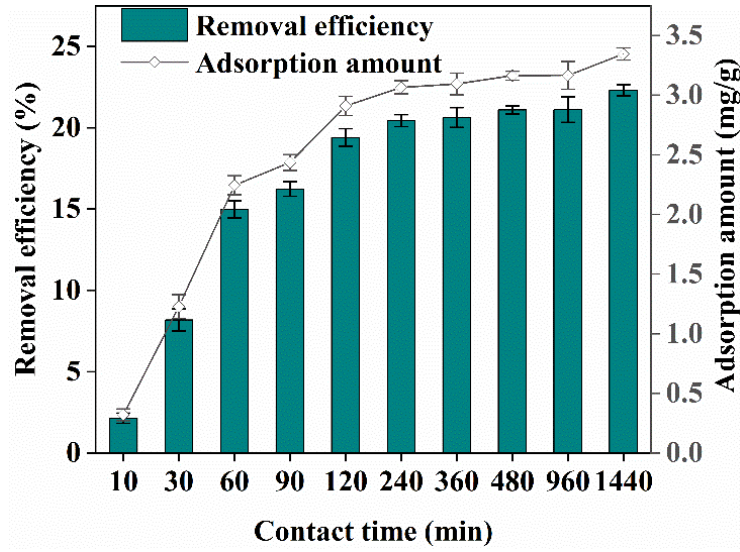
Figure 3. Effect of contact time on Cr(VI)